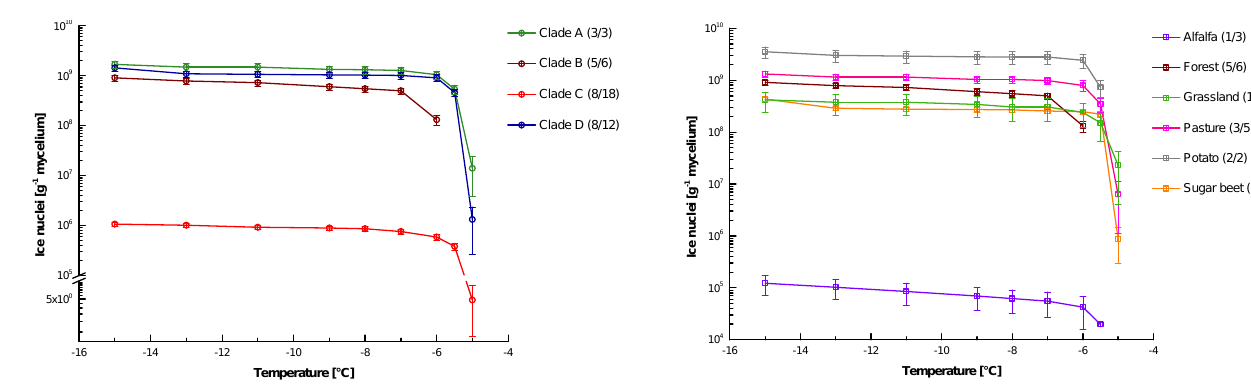
Figure 2. Average number of IN per gram of mycelium (fresh weight) for all clades. The clades are classified as (a) predominantly uncultivated, (b) forest, (c) predominantly standard agricultural, and (d) high organic matter input agricultural. The numbers in paren- theses represent the number of isolates tested out of total number of isolates from each clade. Error bars represent the 95% confidence intervals.